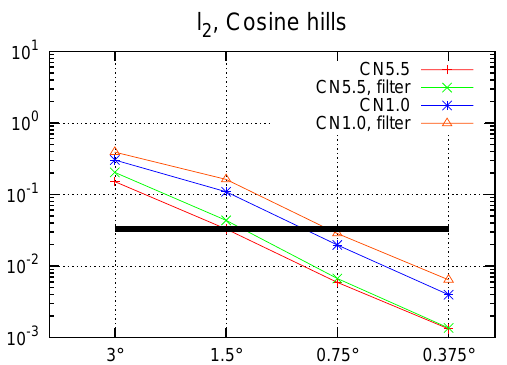
The experimental setup is as in section 3.2, that is, use the non-divergent wind field ((18) and (19)) and cosine bells initial condition (11). At half time, t = T/ 2 , the filament preservation diagnostic ‘ f ( τ,t = T/ 2) is computed at 19 equi-distant discrete intervals ( τ = 0.10, 0.15, 0.15,0.20, ..., 390 0.95, 1.00) without and (if applicable) with limiters/filters at ∆ λ = 1 . 5 ◦ , ∆ λ = 0 . 75 ◦ as well as at the ‘minimal’ resolution ∆ λ = ∆ λ m . The filament diagnostic should be computed as a function of τ ∈ [0 . 1 , 1 . 0] (see Fig.6). The threshold value for which ‘ f ( t = T/ 2) is less than,for example 80, is a mea- 395 sure for how well filaments are preserved. Numerical diffusion will tend to decrease ‘ f for large τ values (maxima decrease) and increase ‘ f for low τ values (gradients are ‘smeared’). An ‘extreme’ situation is shown on Fig. 6(a) where ‘ f is plotted as a function of τ for the 400 highly diffusive 1 st -order version of CSLAM. This much improves when using the higher-order version of CSLAM (Fig. 6(b)). Note that the non-shape-preserving versions of CSLAM produce values of ‘ f less than 100.0 for low thresh- old values ( τ < 0 . 1 ). This also indicates an error in tracer 405